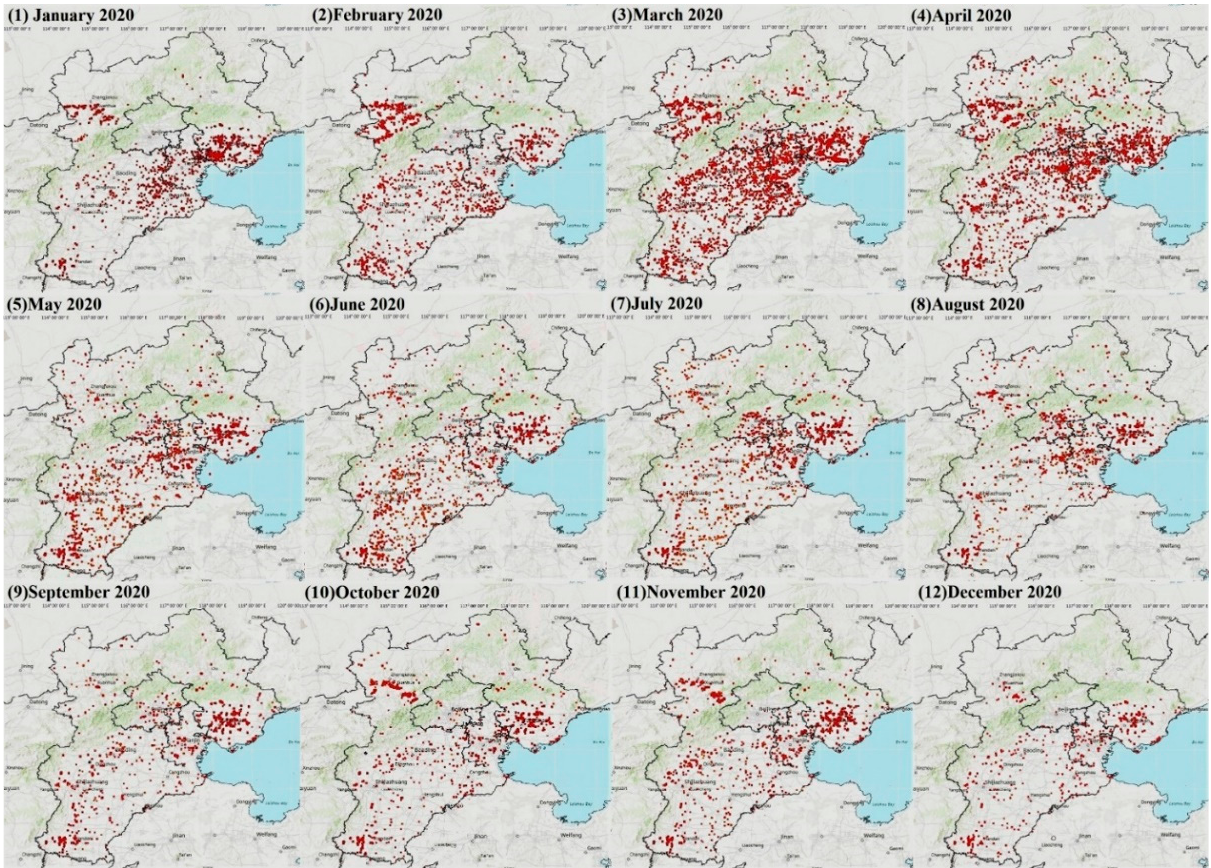
Figure 7. Monthly fire counts topographic map of BTH in 2020. According to the C emissions of BTH, the emissions of CO 2 were the highest, with the monthly average accounting for 8.3% of the cumulative CO 2 , the emissions of particulate matter were the lowest, and its monthly average also accounted for 8.3% of the